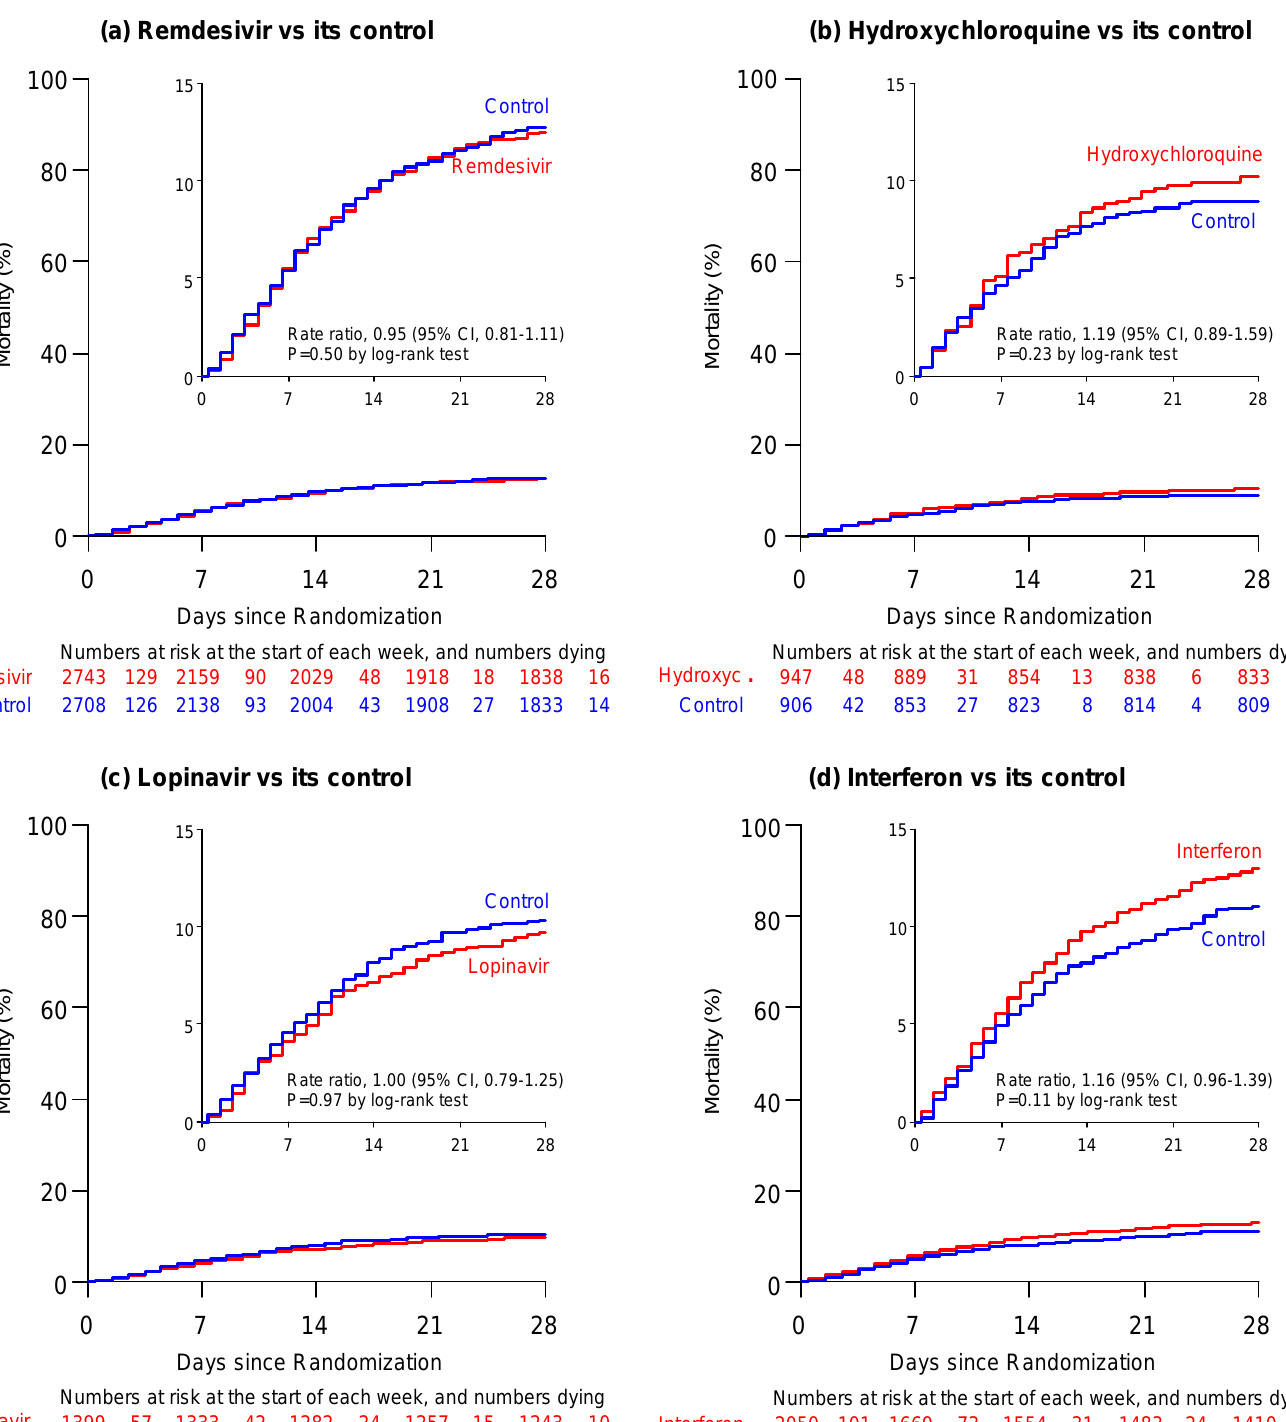
Figure 2. Effects of (a) Remdesivir, (b) Hydroxychloroquine, (c) Lopinavir, and (d) Interferon on 28-day mortality Kaplan-Meier graphs of in-hospital mortality. The inset shows the same data on an expanded y-axis.